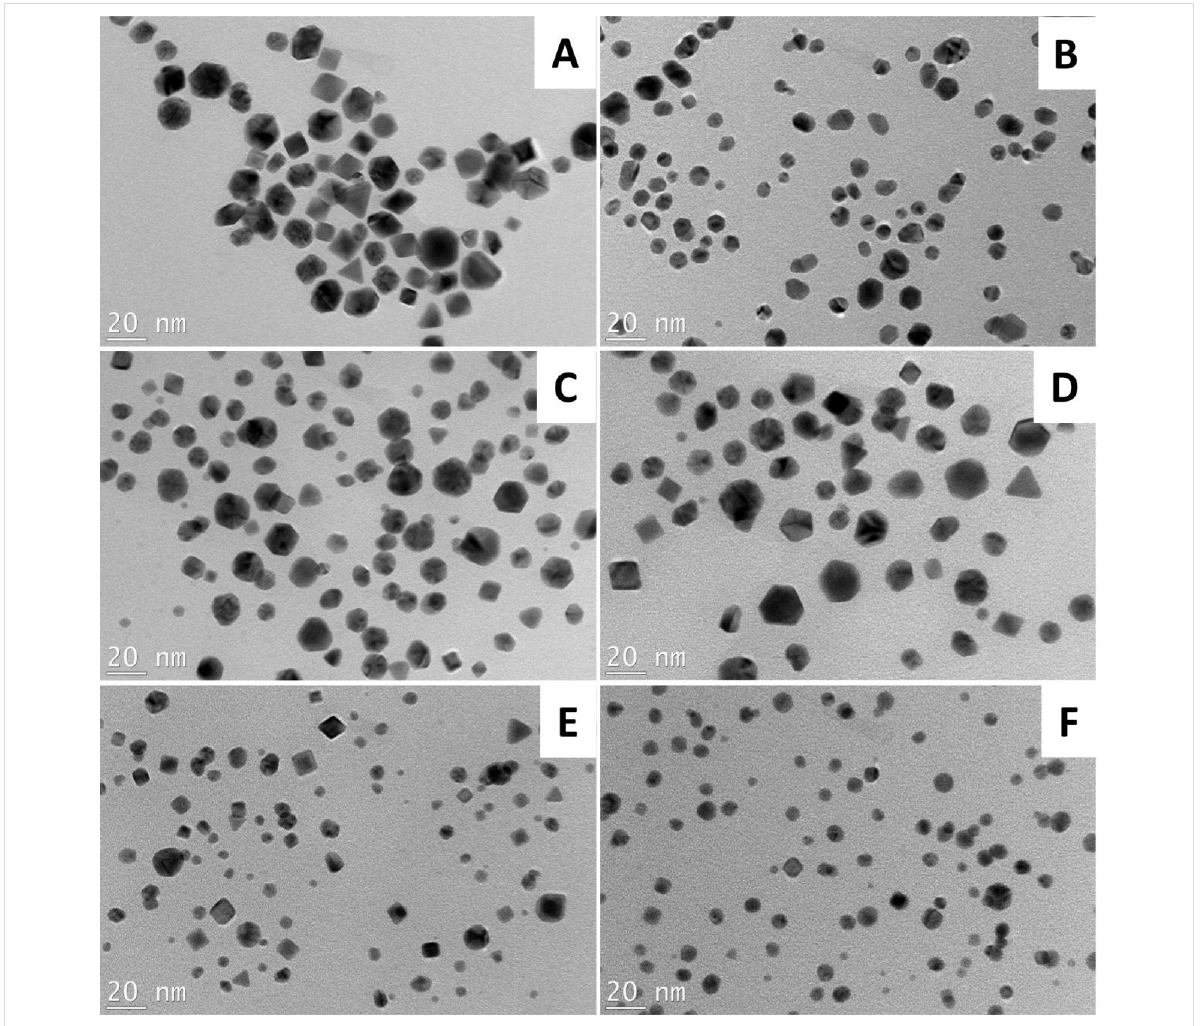
Figure 2: TEM images of the AuNPs (0.5 mM) prepared by using different proteins: (A) HIS, (B) LYS, (C) OVA, (D) BHG, (E) BSA and (F) BGG. Scale bar: 20